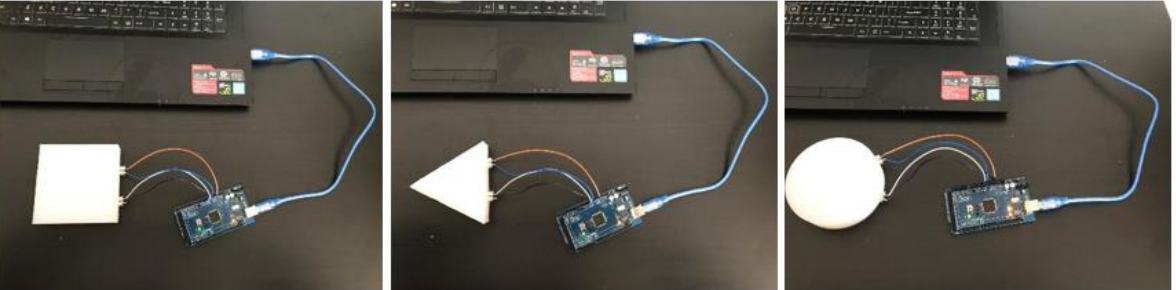
Figure 4. Set-up of silicon experiment modules.